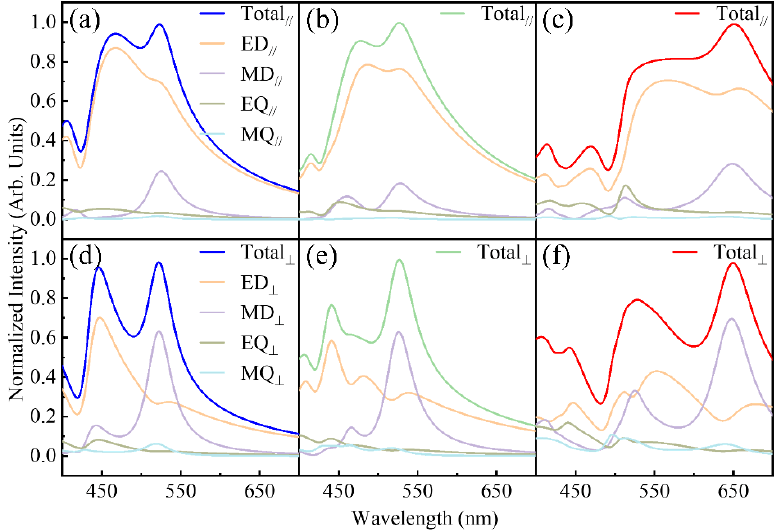
Figure 8. Simulated light-scattering spectra with mode decomposition under ( a – c ) longitudinal ex- citation and ( d – f ) transverse excitation. ( a , d ) D120&80, ( b , e ) D120&&100, ( c , f ) D120&160. ED: